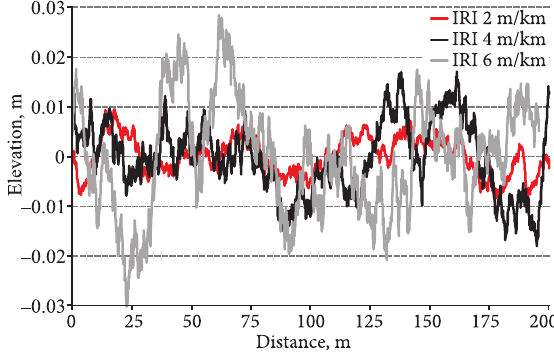
Fig. 4. Tested road profile for chosen IRI value